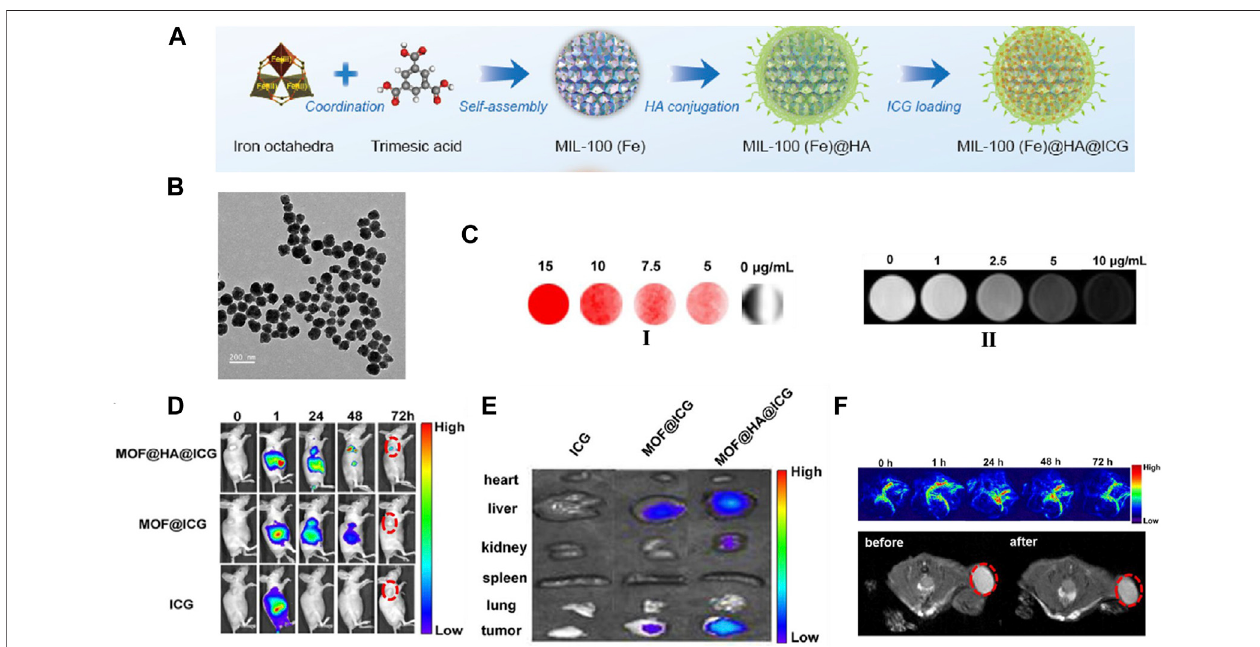
FIGURE 10 | (A) Schematic description of the synthesis process of HA conjugated, ICG loading of MIL-100(Fe) nanomaterial. (B) TEM images of the MOF@HA@ ICG NPs. (C) FLimages (I)andT2-weighted MR images(II) ofcellstreatedwithMOF@HA@ICGsolutions. (D) FLimages ofMCF-7 tumor-bearing miceinjected withfree ICG, MOF@ICG, orMOF@HA@ICG solutions(eachwith170 μ g/mlofICG;thetumors arehighlightedbyredcircles). (E) Invitro FLimages oforgans(heart,liver,kidney, spleen,andlung)andtumors. (F) Invivo PAimagesandT2-weightedMRimageswithMOF@HA@ICGtreatment.Thetumorsarehighlightedbyredcircles.Source: (Li et al.,